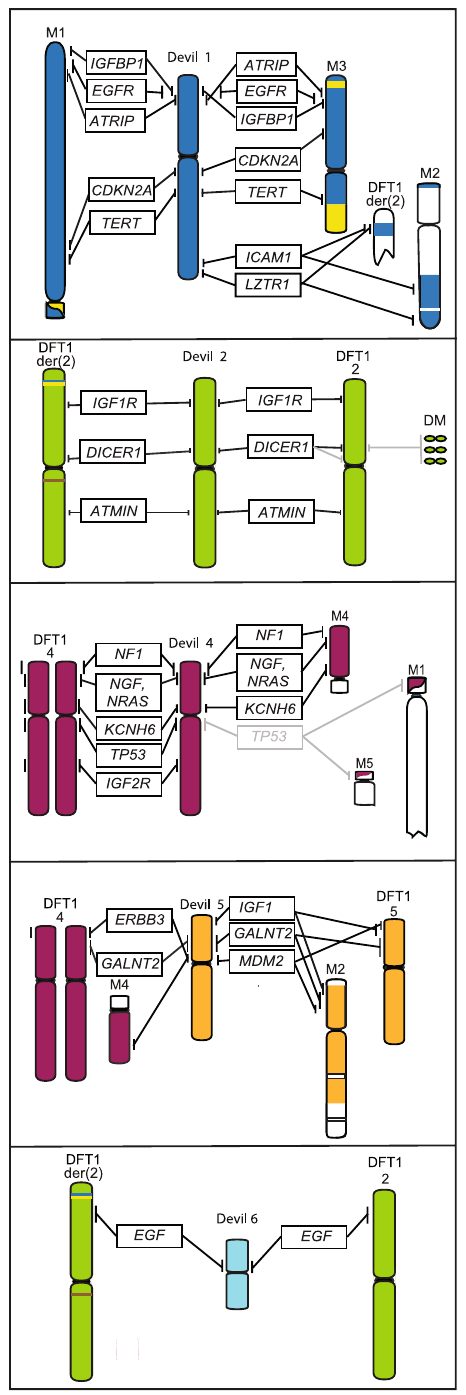
Figure 5. Location of cancer-related genes on devil and DFT1 chromosomes. Genes in grey indicate variations observed between